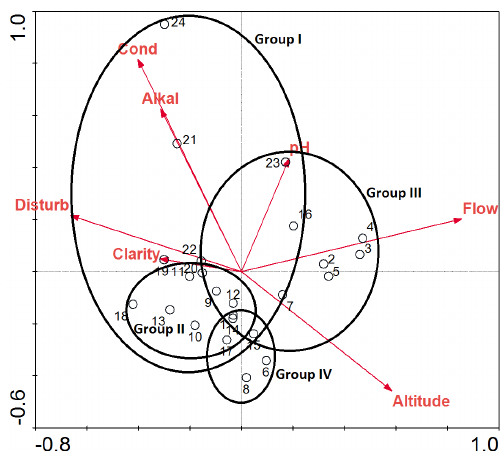
Figure 2. CCA site ordination plot with TWINSPAN sample-groups overlain, showing relation between envi- ronmental variables and 4 site-groups (I: characterised by abundant Gerridae, Gyrinidae, Culicoidae, and Ampularidae; II: Baetidae (single species), Oligochaetae; III: Coenagrionidae, Libellulidae, Baetidae (>1 species), Atyidae and Leptoceridae; IV: abundant